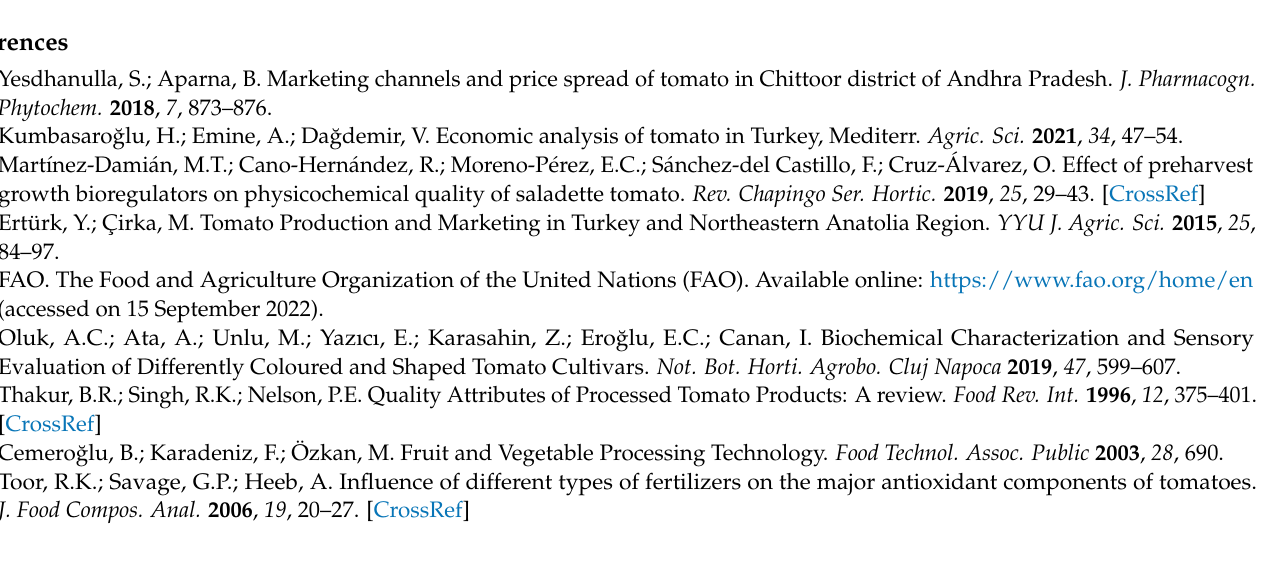
treatments; Table S2: SPAD results for different irrigation treatments; Table S3: Macronutrients results for different irrigation treatments; Table S4: Micronutrients results for different irrigation treatments; Table S5: Results of leaf area, leaf area index and average number of leaves per plant (pcs.) for different irrigation treatments; Table S6: Yield results for irrigation